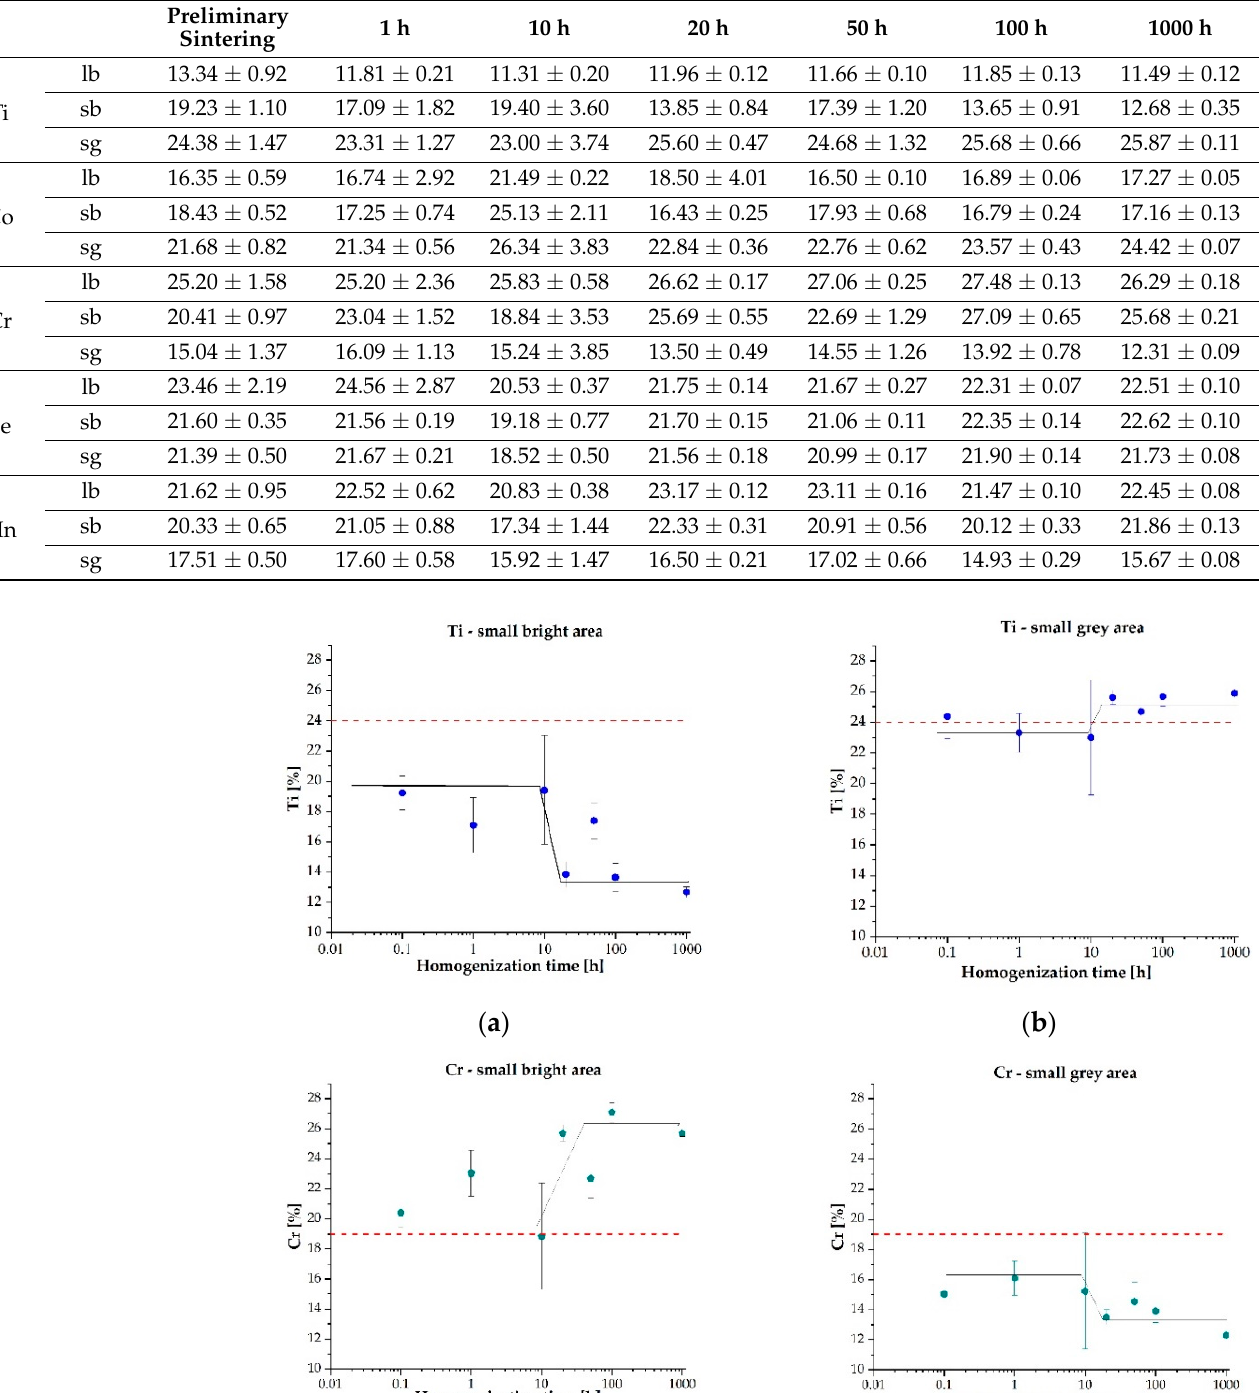
Table 2. The contribution of individual elements (at. %) with the standard deviation for three observed phase areas: large bright area (lb), small bright area (sb) and small grey area (sg) of TiCoCrFeMn sintered and annealed at 1000 ◦ C alloy.